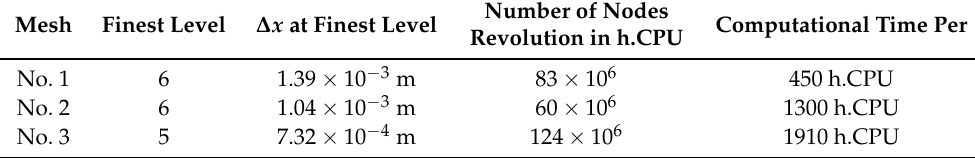
Table 2. Meshes selected for the LBM mesh sensitivity study. The finest level is the numerical domain surrounding the rotor of the turbine. h . CPU is the wall-clock time multiplied by the number of CPU used. ∆ x at Finest Level Number of Nodes Computational Time Per Revolution in